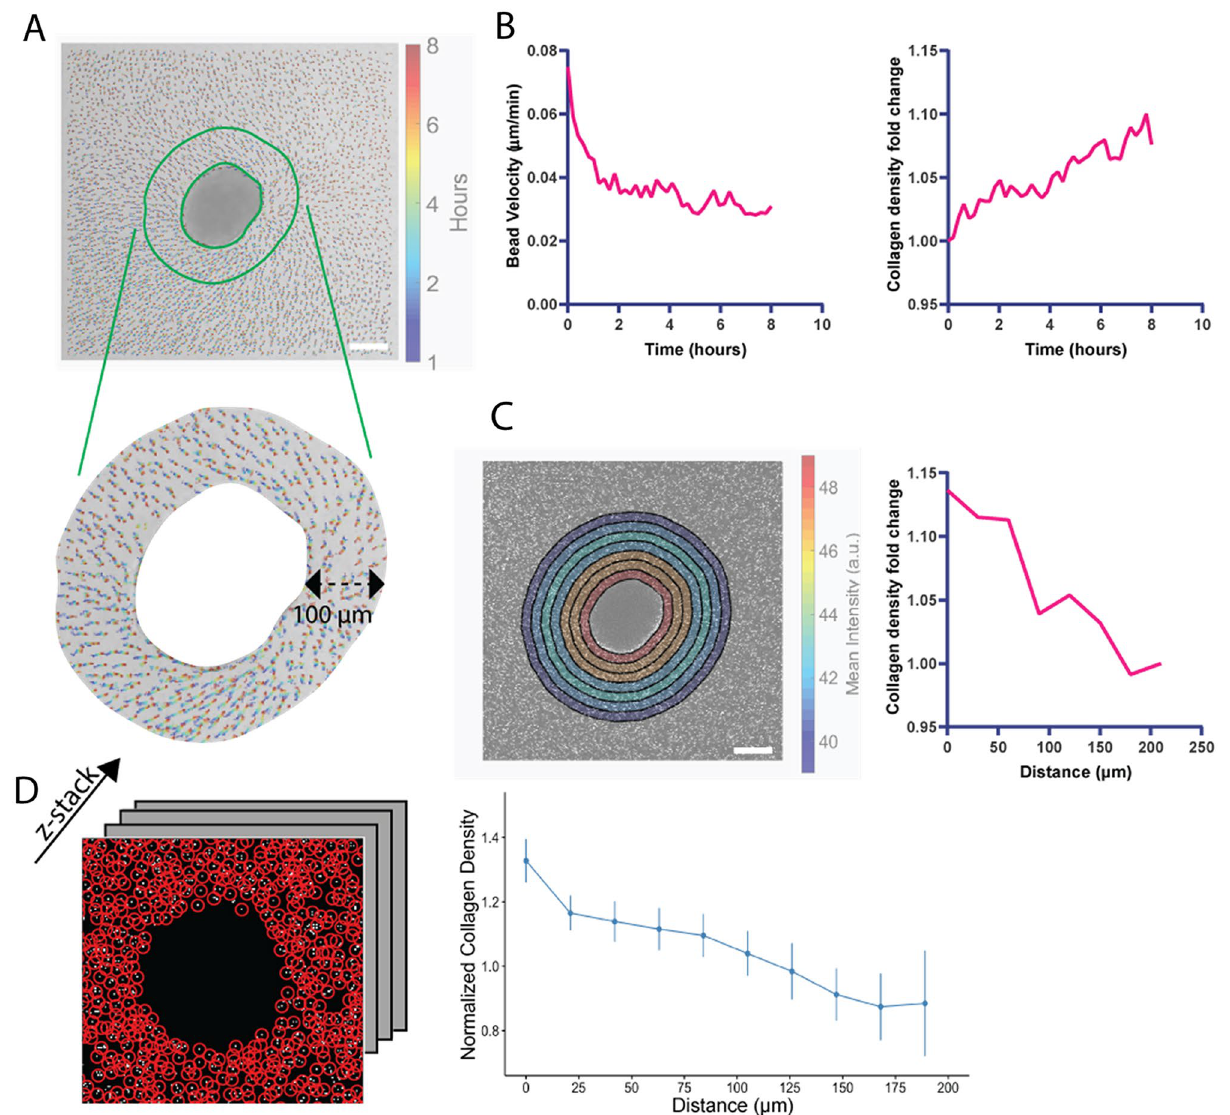
Figure 2. Analytical metrics: bead velocity and collagen density. ( A ) Example image of bead trajectory tracking using the Blair and Dufresne routine for an IPF spheroid with the color indicating time. The cut-out ring (bottom) is where mean intensity or bead velocities are averaged. Scale bar: 100 μm. ( B ) Mean velocity of the beads decreases over time (left), and collagen density increases over time (right). ( C ) Collagen density decreases with an increasing distance away from the spheroid, shown in the heatmap (left) and its profile plot (right). The analyzed image is a spheroid cultured in collagen for 6 h. ( D ) Example image of collagen bead tracking via TrackPy. Dark region in the middle is a spheroid. Its profile plot is on the